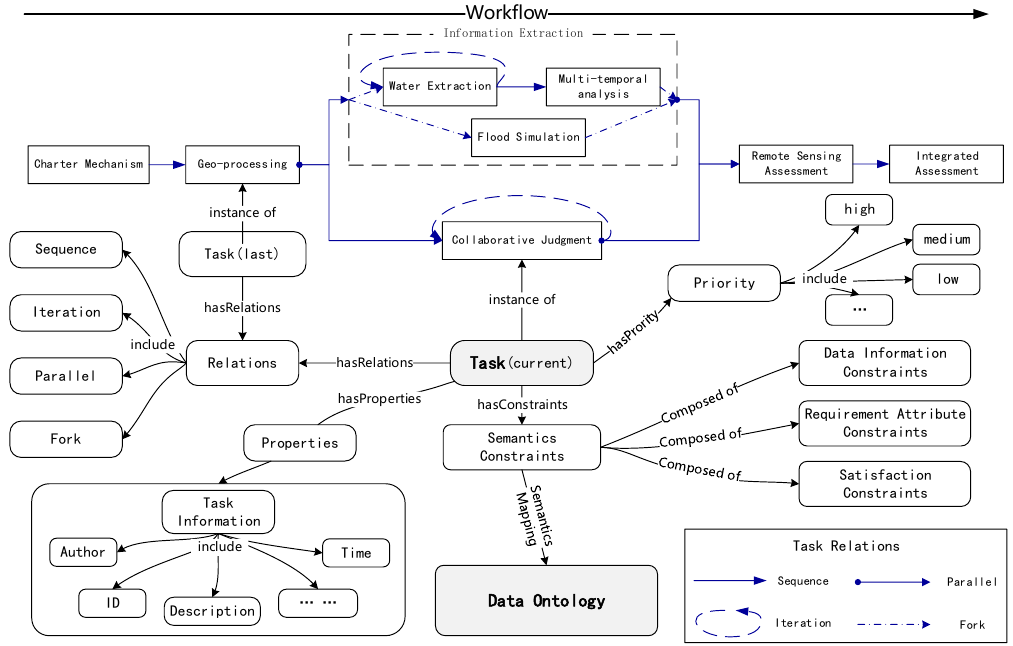
Figure 1. Structure of a task ontology in an emergency response workflow